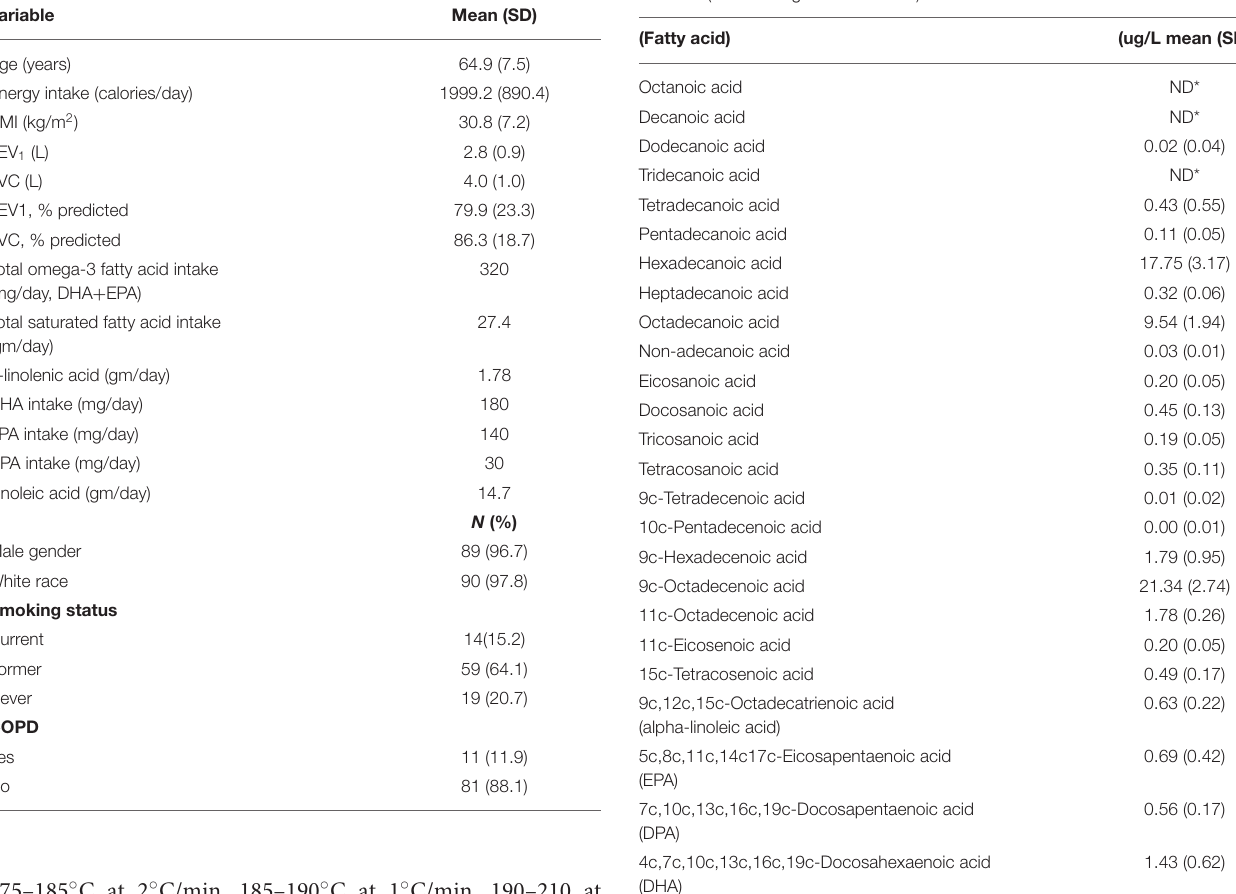
TABLE 2 | Demographic characteristics of participating veterans ( n = 92). TABLE 3 | Fatty acid percent of total fatty acids in plasma of participating veterans (normal ranges not